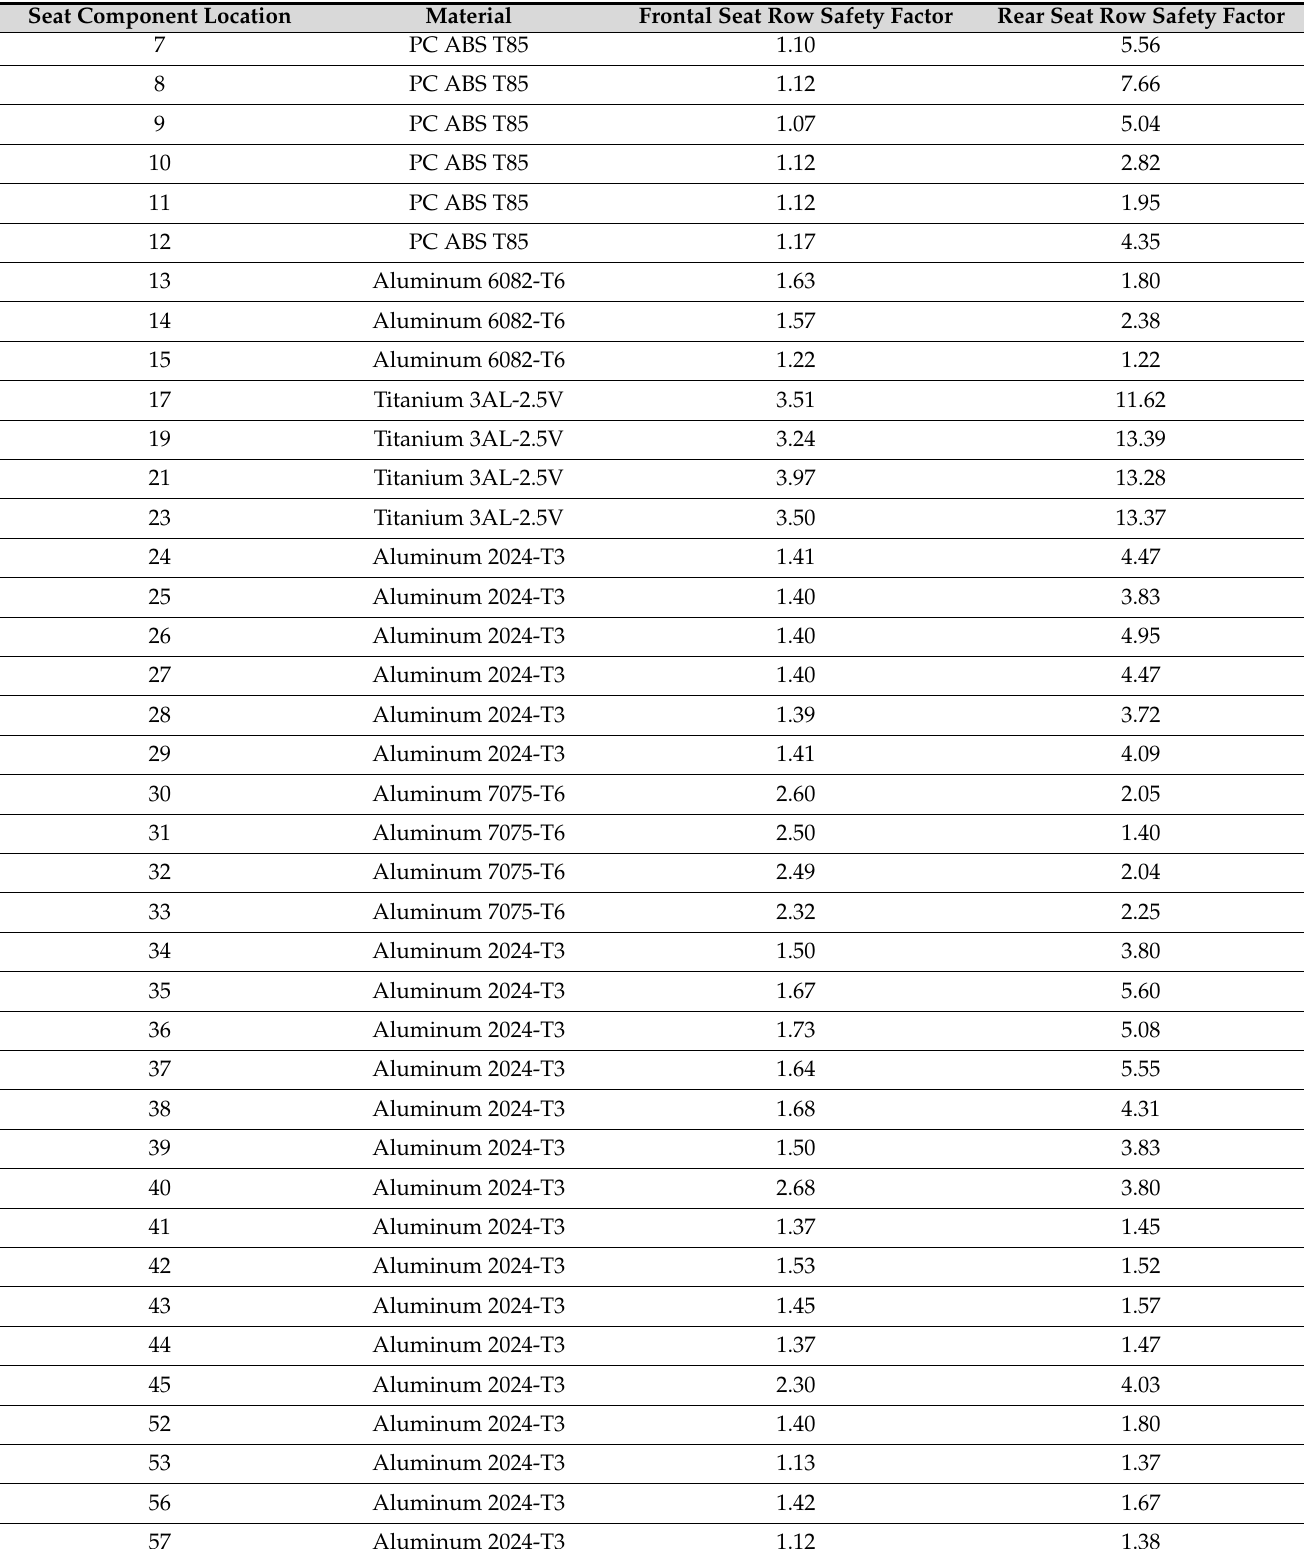
Table 10. Isotropic material safety factor against the fraction for test